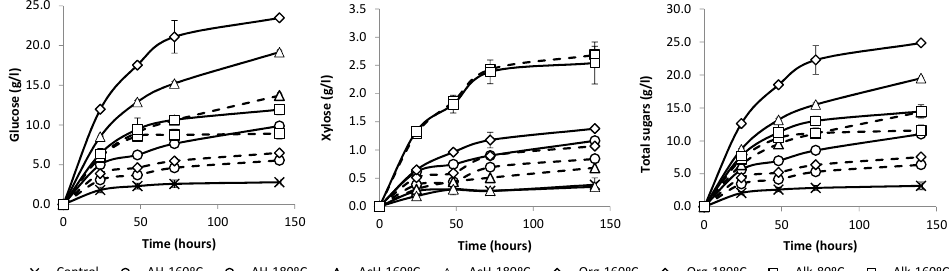
Figure 6. Time course of sugars production during enzymatic hydrolysis of the pretreated materials (WIS fraction) resulting from the different pretreatments of Ademuz elm clone. AH, autohydrol- ysis pretreatment; AcH, acid hydrolysis; Org, organosolv pretreatment; Alk, alkaline extraction. Mean values and standard deviations were calculated from the